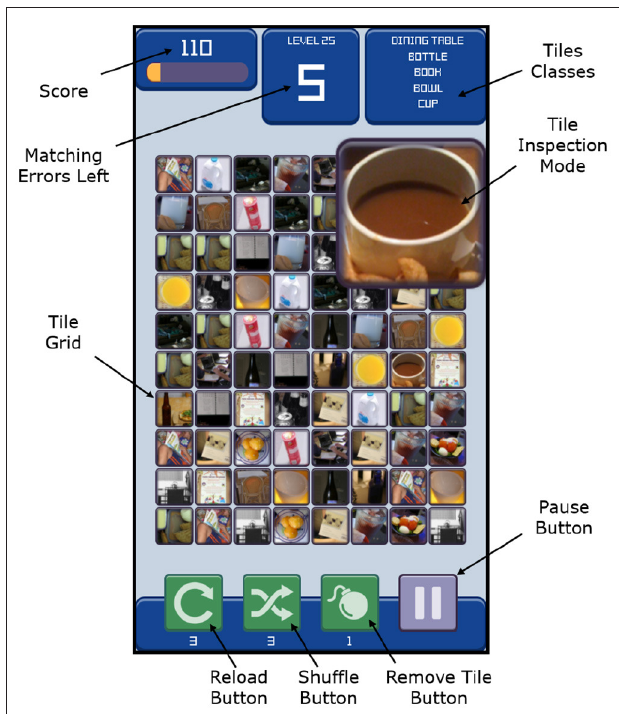
FIGURE 2 | Interface of the developed tile-matching game. The player matches adjacent tiles based on the classes listed in the top right corner. To facilitate attribute recognition of individual tiles, they can be enlarged using the tile inspection mode. If connected tiles share the same attribute, they disappear and increase the player score. The number of permitted matching errors per level is limited, which encourages the player to inspect the tiles closely before connecting them. If players are stuck on a level, they can utilize boosters that can either reload the board, shuffle the tiles, or remove a specific type of tile. The game is compatible with Windows, Linux, Android, iOS, and HTML5 to allow running in a web